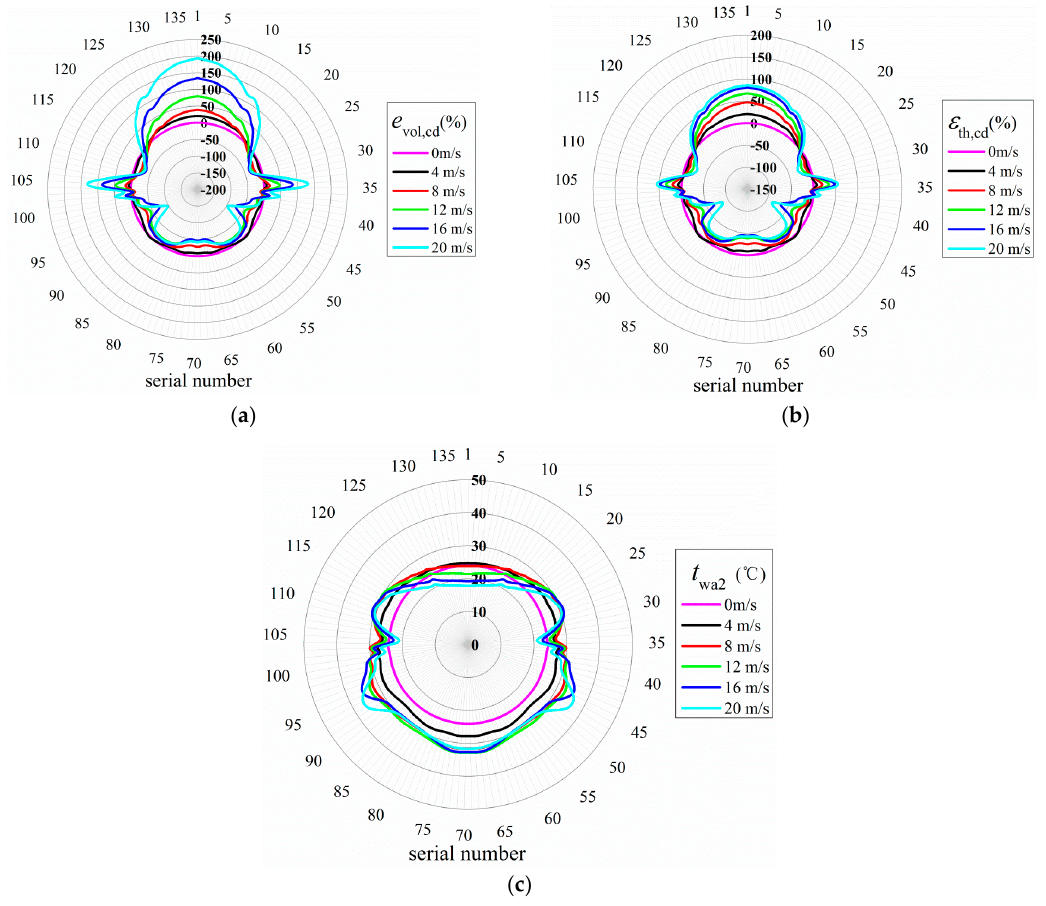
Figure 15. Performance distributions for case D. ( a ) Volume effectiveness; ( b ) Thermal efficiency; ( c ) Outlet water temperature.